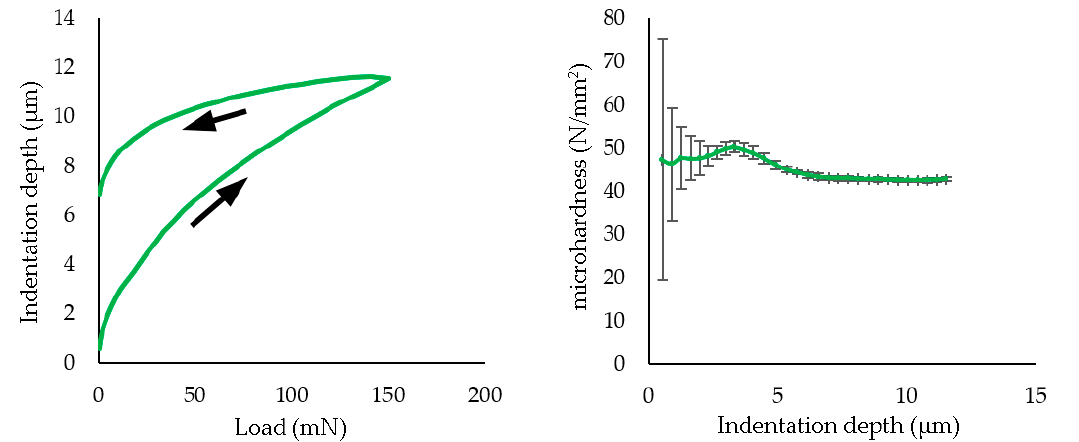
Figure 5. The load–unload curves ( left ) and microhardness ( right ) measured in the PFA coatings.